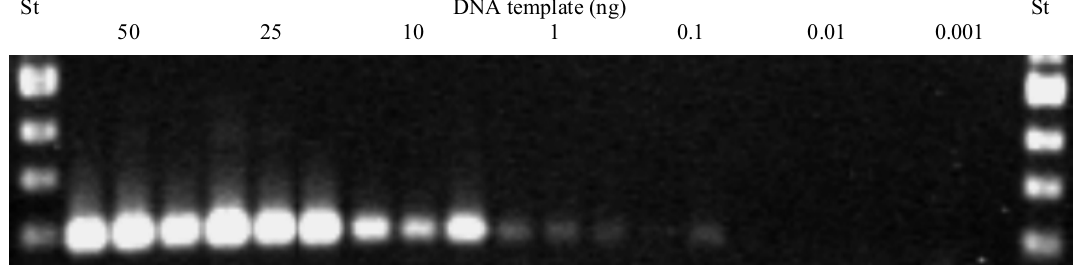
Fig. 6. Example of SCAR primer sensitivity. Three Phaeomoniella chlamydospora isolates were tested at each con- centration of DNA template. The PCR amplifications were carried out using the primer pair specific for P. chlamy- dospora , yielding a 191 bp amplification product. St,